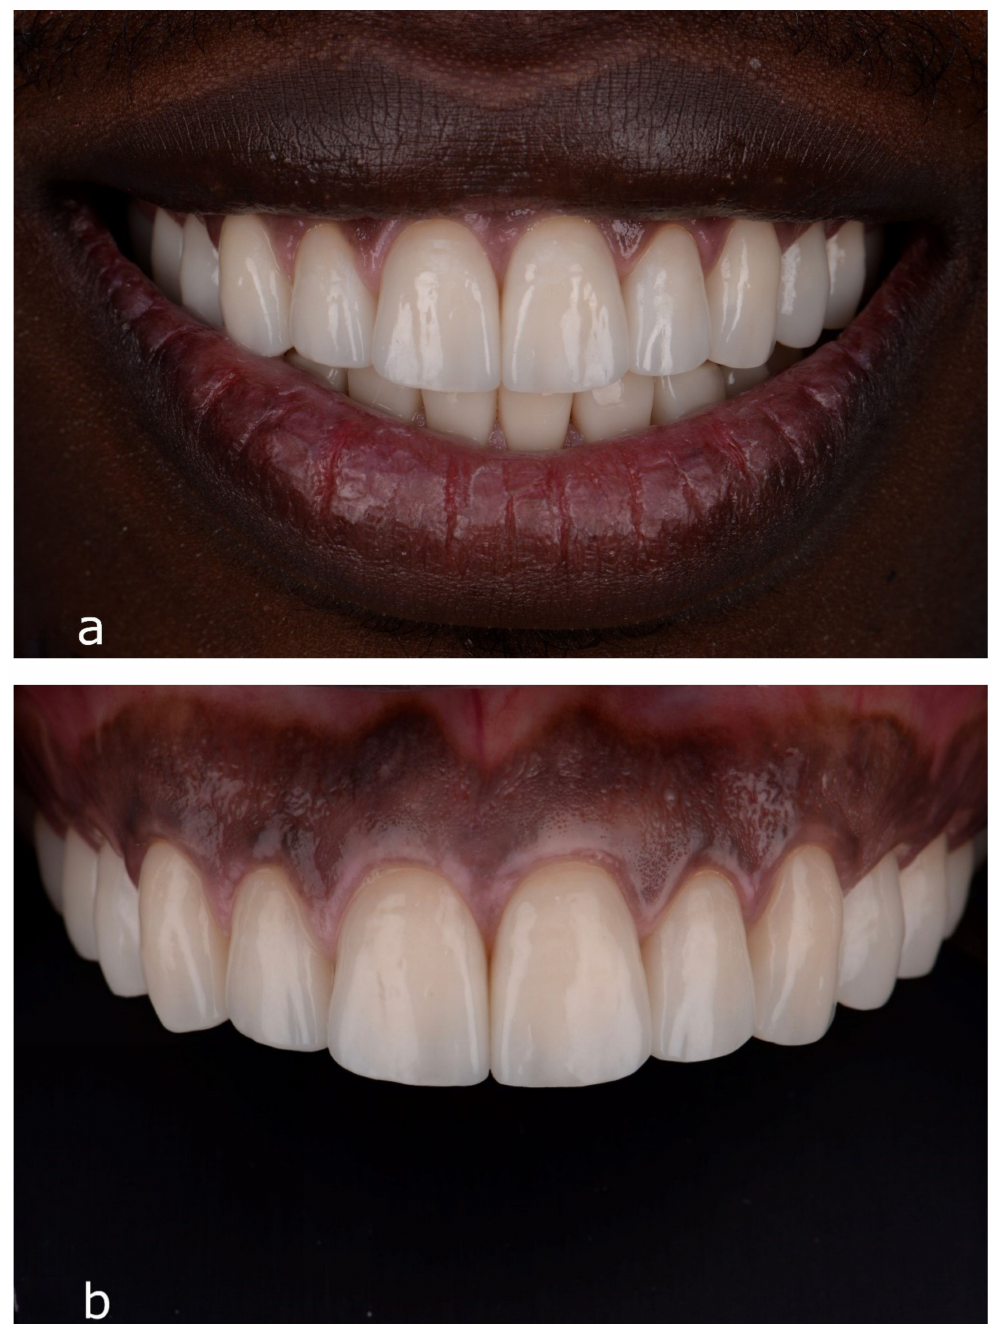
Figure 11. Six-month follow-up: ( a ) patient at full smile with final restorations and ( b ) retracted frontal view of the final maxillary anterior